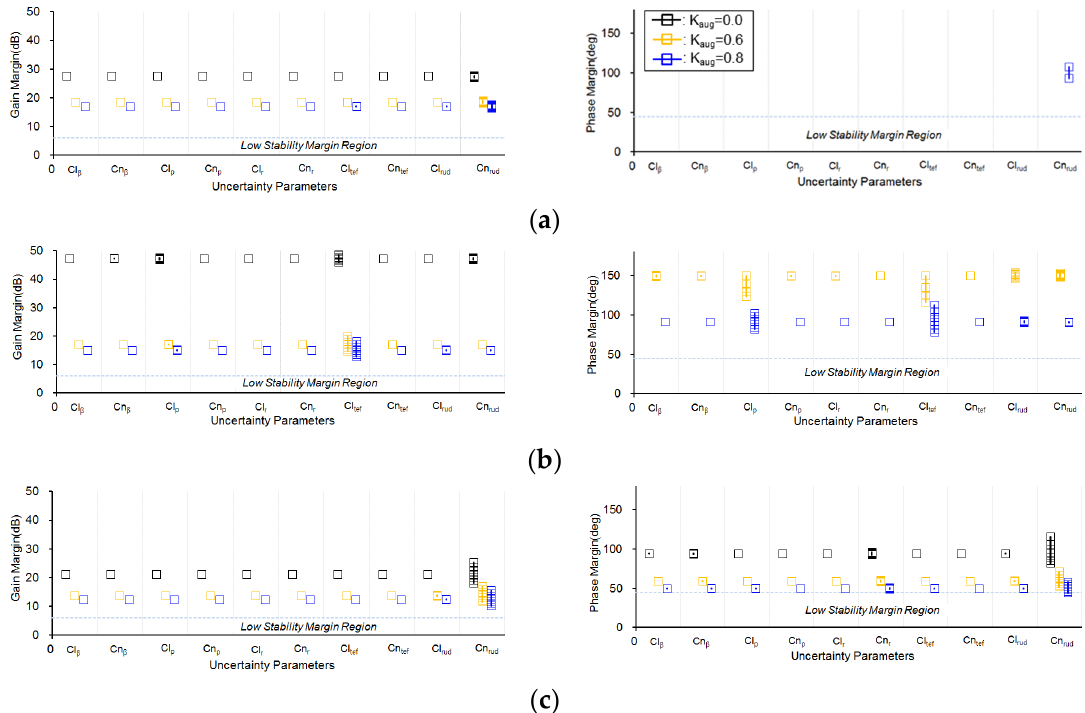
Figure 8. Stability margin analysis results of the control system on various uncertainties in M0.8, 20 Kft altitude ( a ) asym- metric HTs, ( b ) asymmetric flaperon, ( c ) rudder.